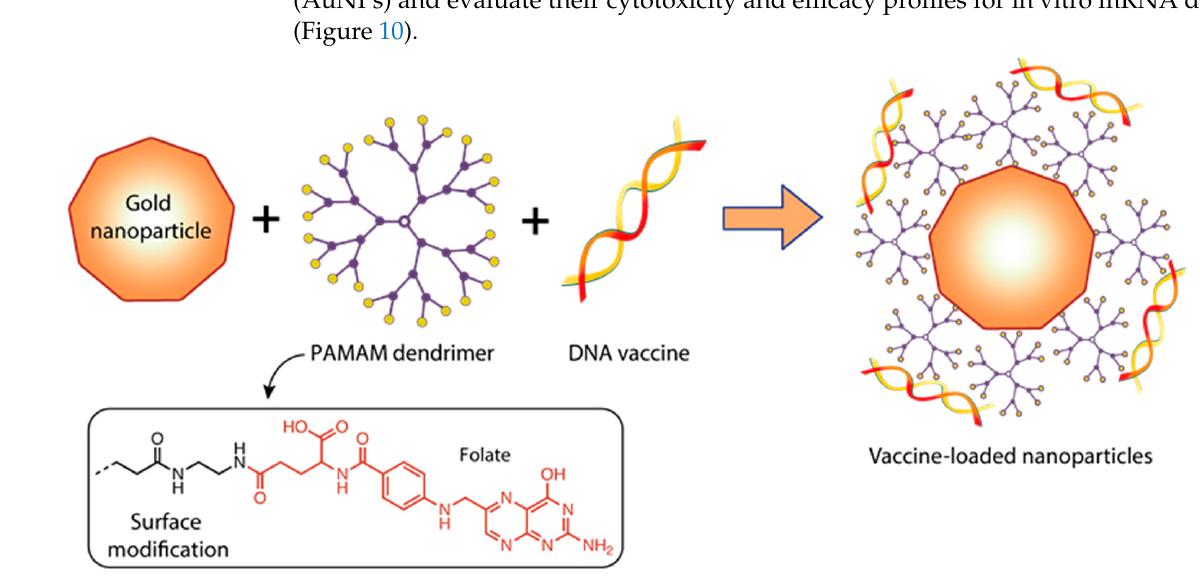
Figure 10. Constructing vaccine nanoformulations based on dendrimer-functionalized gold nanoparticles.